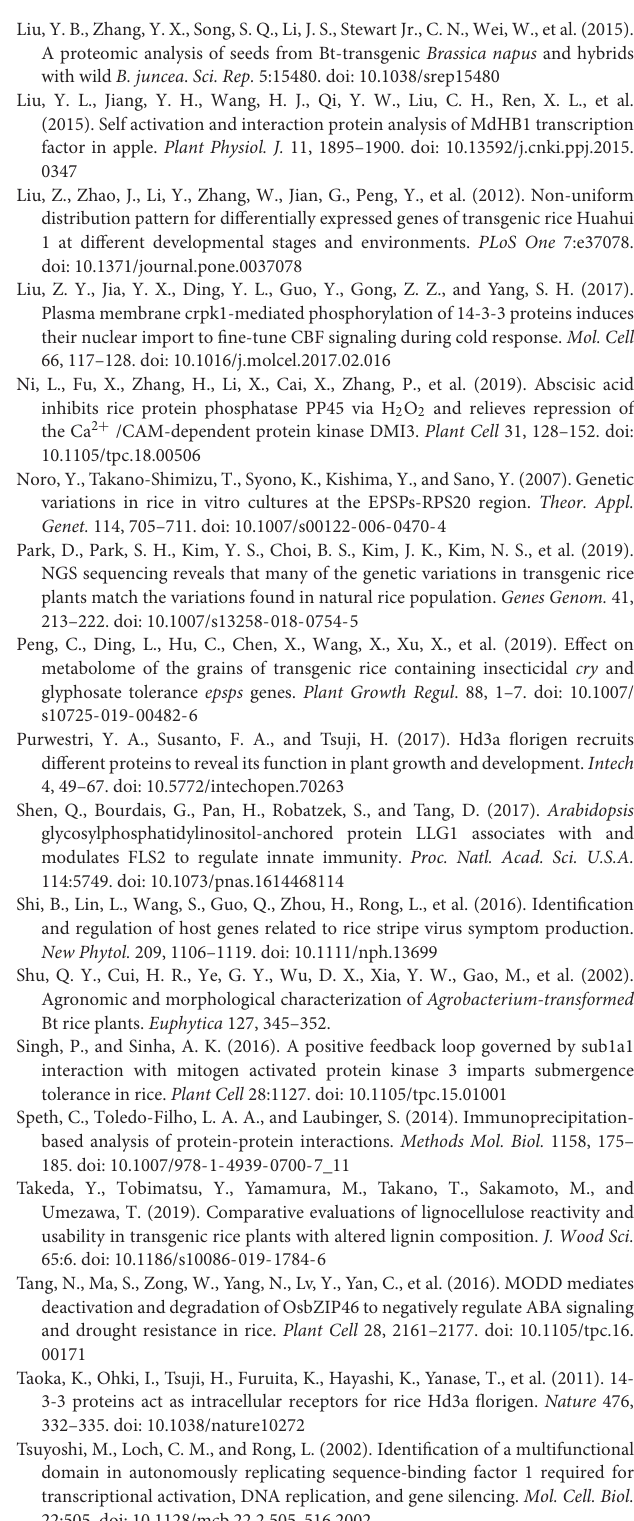
TABLE S1 | Primers used for cloning the full-length gene based on subcellular co-localization and co-immunoprecipitation